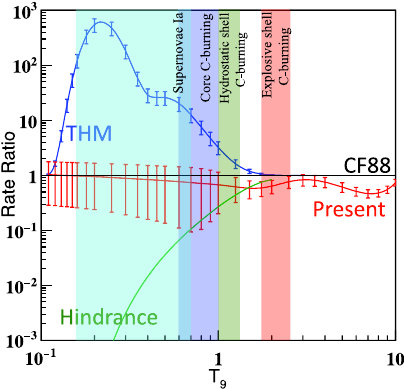
Fig. 13. (color online) Rates relative to CF88 rate [42] ob- tained in the present study (red) along with rates based on Figure 6. The relative reaction rate obtained in the current work (Red) together with the rates based on the THM measurement [35] (blue) and hindrance model the THM measurement [30] (Blue) and hindrance model [28] (Green) to the CF88 rate [22]. Tempera- [43] (Green). Temperatures for the type Ia supernovae ( T = 0.15-0.7 GK), core carbon burning ( T = 0.6-1.0 GK), hy- tures for core carbon burning (T = 0.6-1.0 GK), hydrostatic shell carbon burning (T = 1.0-1.2 GK), and drostatic shell carbon burning ( T = 1.0-1.2 GK), and explos- explosive shell carbon burning (T = 1.8-2.5 GK) are marked by colored ive shell carbon burning ( T = 1.8-2.5 GK) are marked by colored